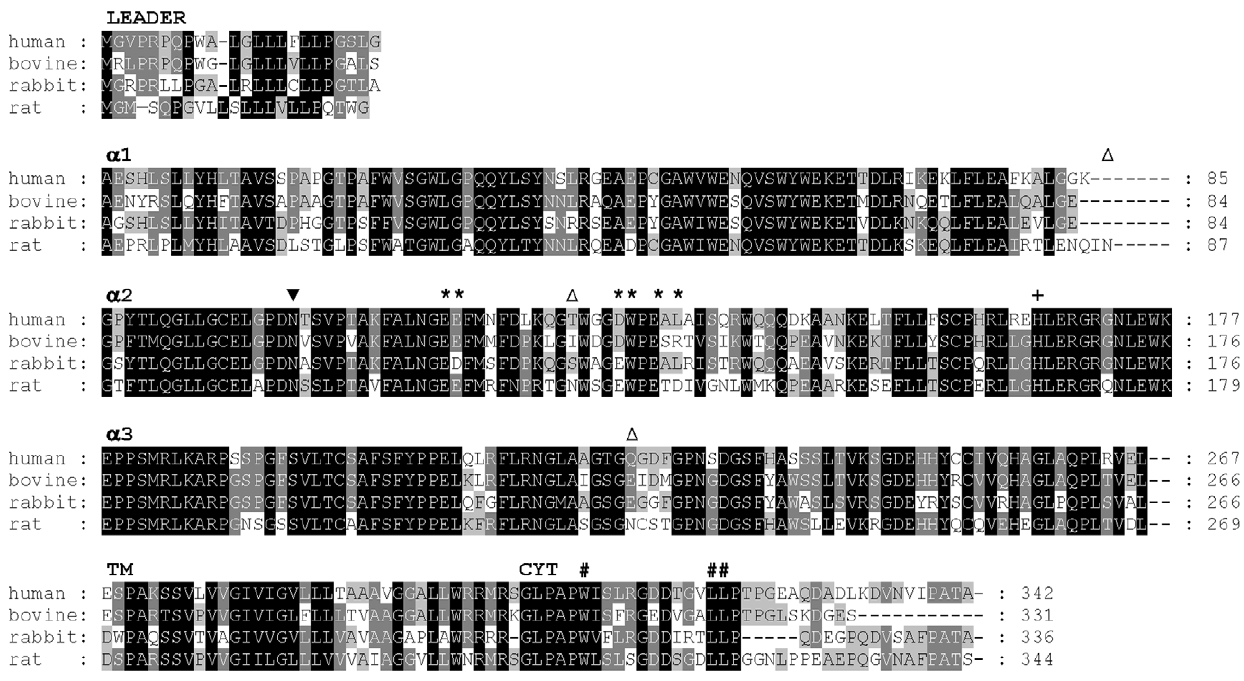
Figure 2. Domain-by-domain alignment of the predicted amino acid sequences for rabbit, human, bovine, rat FcRn a -chain sequences. Structural and functional features are highlighted, potential N-linked glycosylation sites (N-X-S or N-X-T, where X is any amino acid except proline) at positions 87, 128, 225 (present in rat FcRn [9]) and 104 (present in all FcRn species) are indicated by empty and filled triangles to denote non-conserved and conserved sites, respectively. Numbering is based on the rat FcRn sequence. Residues at the interface between rat FcRn and Fc based on a crystallography analysis of a rat FcRn-heterodimeric Fc complex [33] are labelled with asterisks. Conserved His at position 166 is considered to bind to albumin [40] and is indicated by a plus sign. FcRn has been shown to have two endocytosis signals, a tryptophan based motif (W311) and a dileucine motif (L322 and L323) indicated by # characters) [41]. Consensus residues are assigned based on the number of occurrences of the character in the column, emphasizing the degree of conservation. The higher the conservation in a column the darker the background of the character [68].